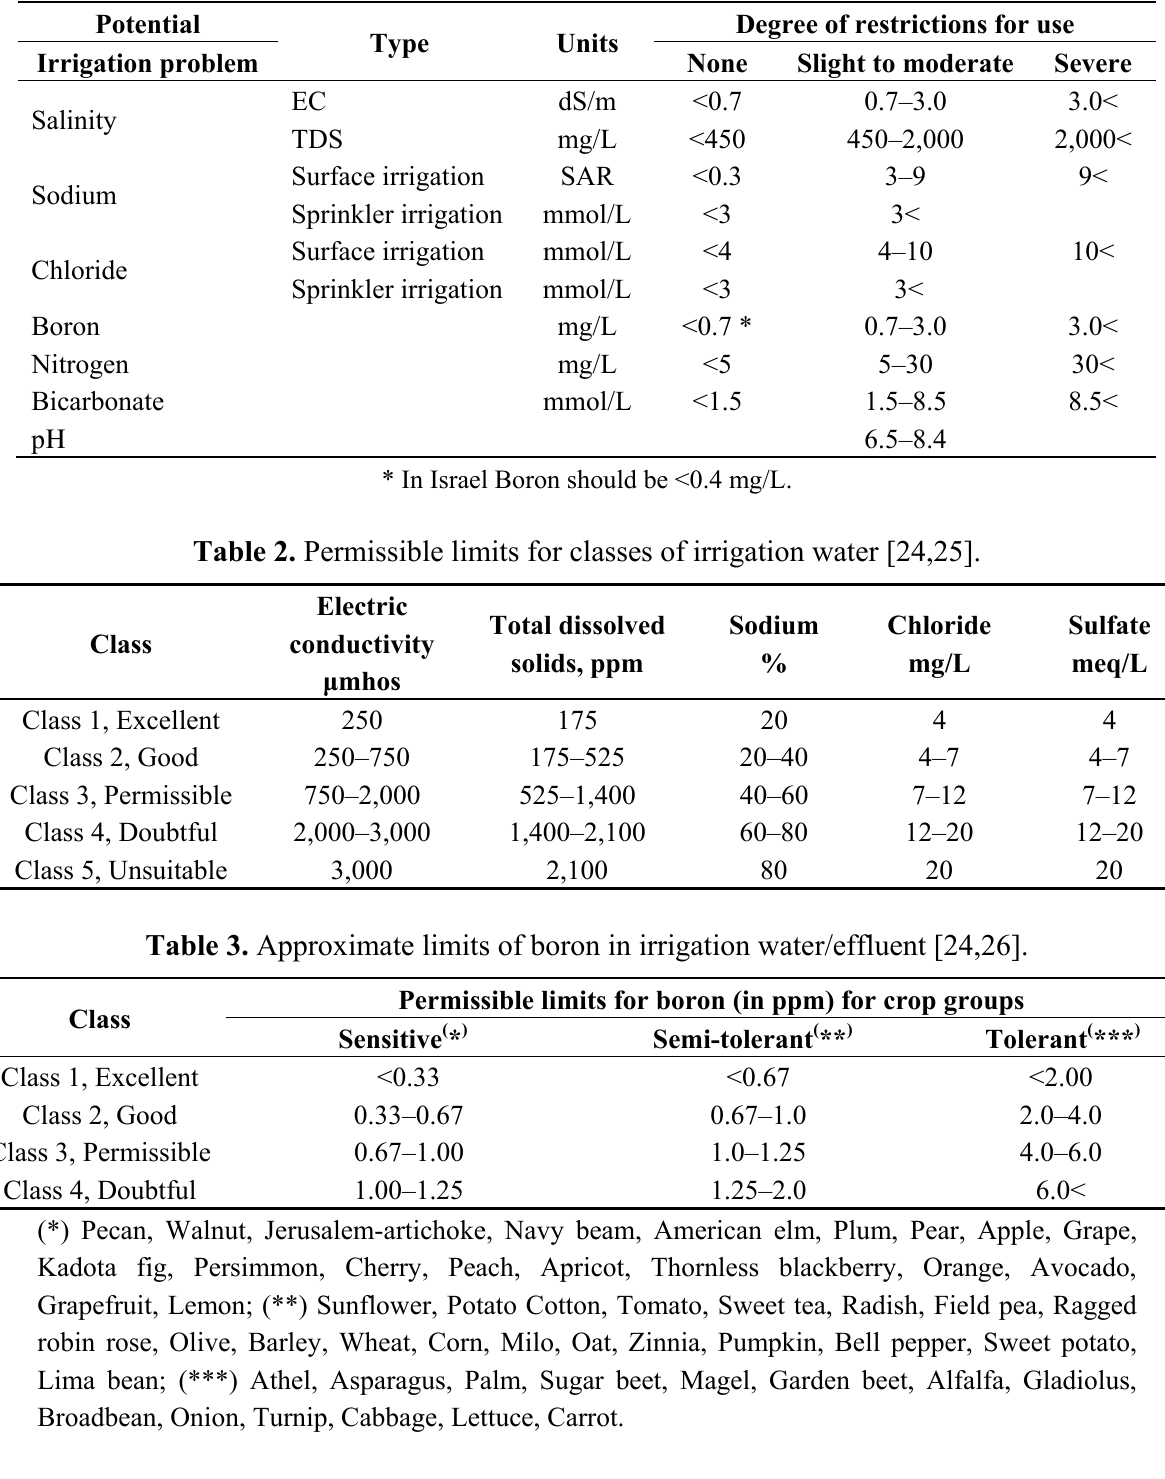
Table 1. Guidelines for interpretation of mineral content in effluent applied for irrigation [24].